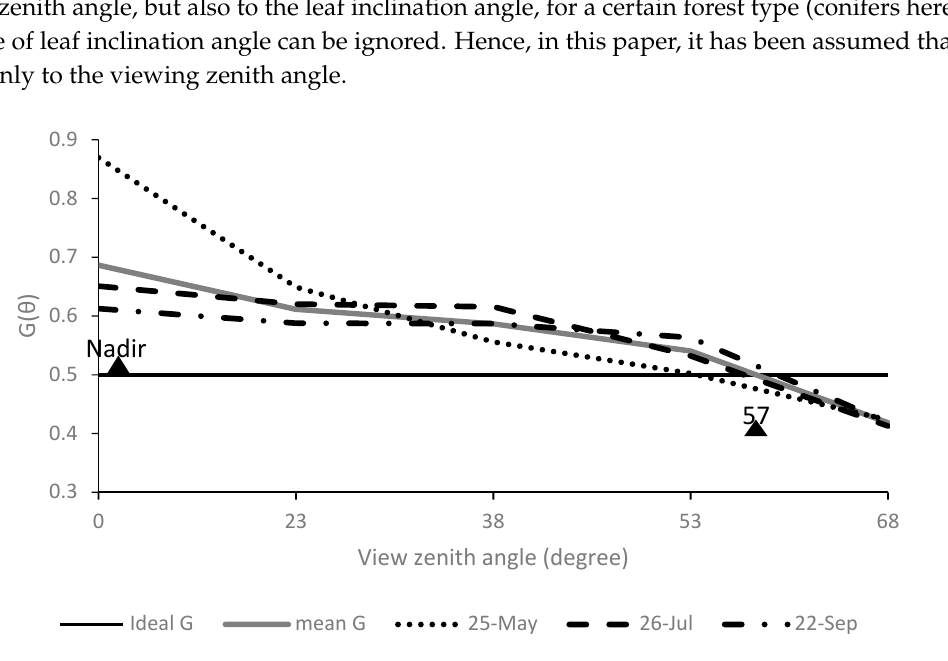
Figure 5. Foliage projection coefficient ( G ) derived from LAI-200 instrument at three dates. The mean G values of the measured LAI G values on the three dates is plotted as grey line, and the ideal G = 0.5 also is plotted as solid black line. The averaged G for LAISmart and PocketLAI are plotted as a solid triangle.